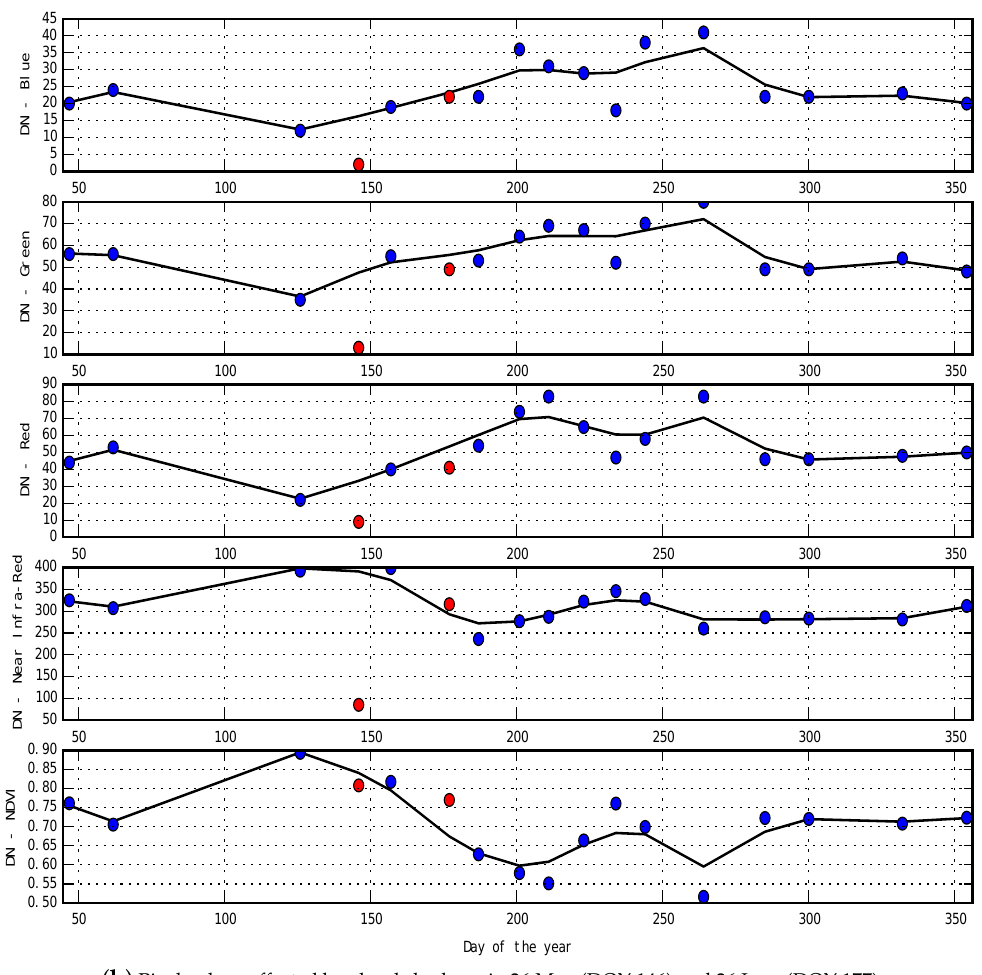
( b ) Pixel values affected by cloud shadows in 26 May (DOY 146) and 26 June (DOY 177) Figure D1. Temporal profiles of spectral bands and NDVI for pixels affected by clouds ( a ) and cloud shadows ( b ) at several days of the year (DOY) in 2013. The noisy values of the pixels within the SITS are labeled in red. The cloud-free and shadow-free values of the pixels are represented in blue. The line represents the temporal profiles after application of the Whittaker